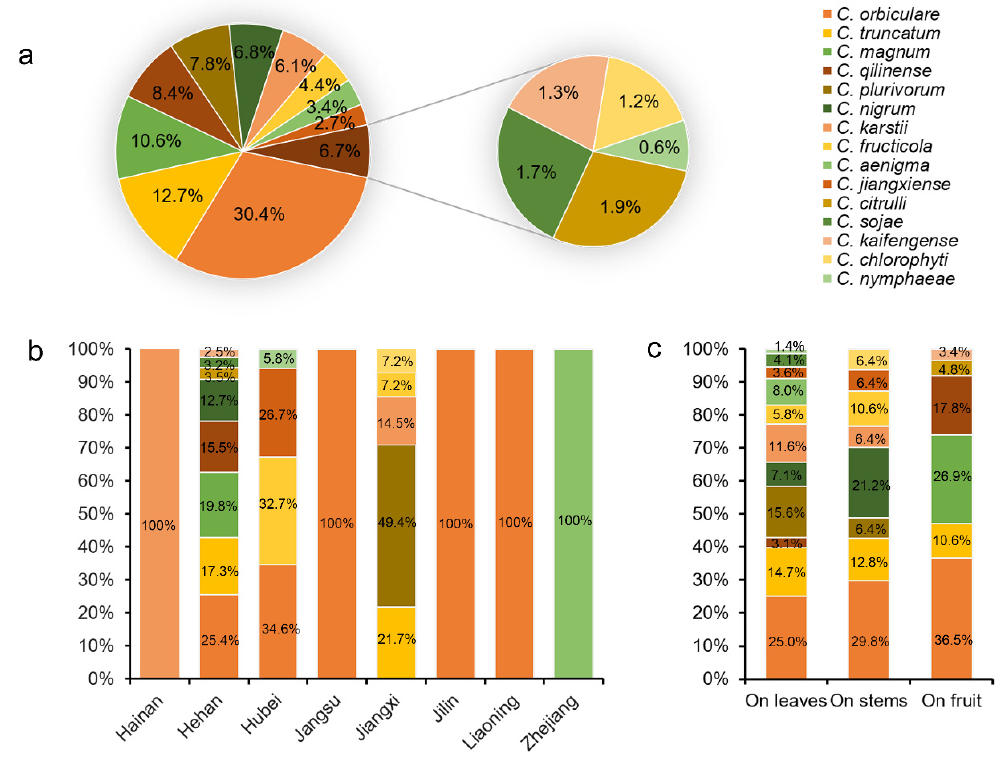
Figure 9. The prevalence of Colletotrichum species isolated from watermelon. ( a ) Overall isolation rate (%) of Colletotrichum species; ( b , c ) isolation rate (%) of Colletotrichum species from part of sam- pled province ( b ) and watermelon organs ( c ),